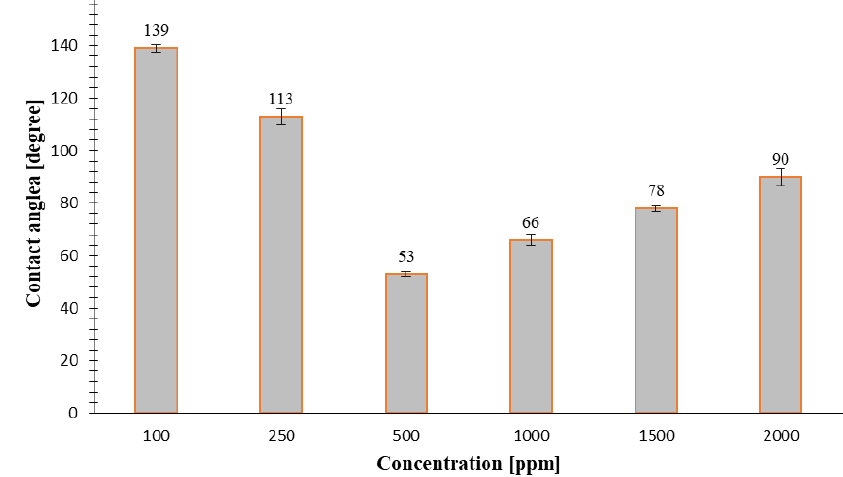
Figure 15. Effect of the prepared nanofluids with different concentrations of the novel NC on wettability (contact angle) alteration in carbonate rock samples.